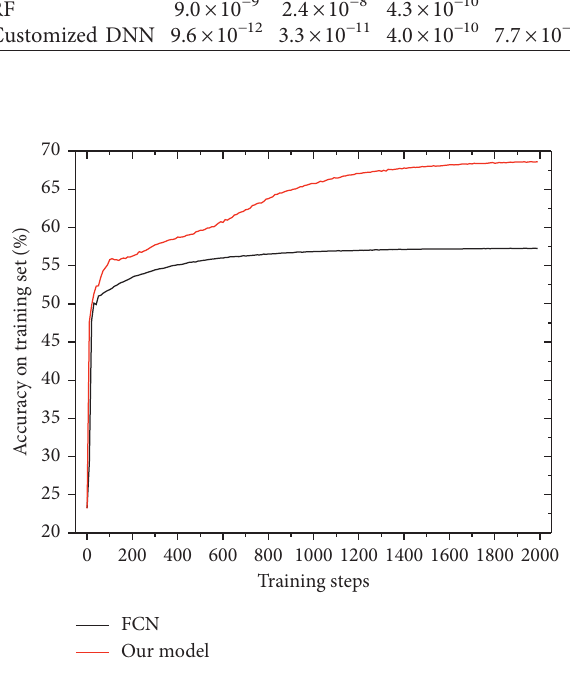
Figure 5: Curve of the training